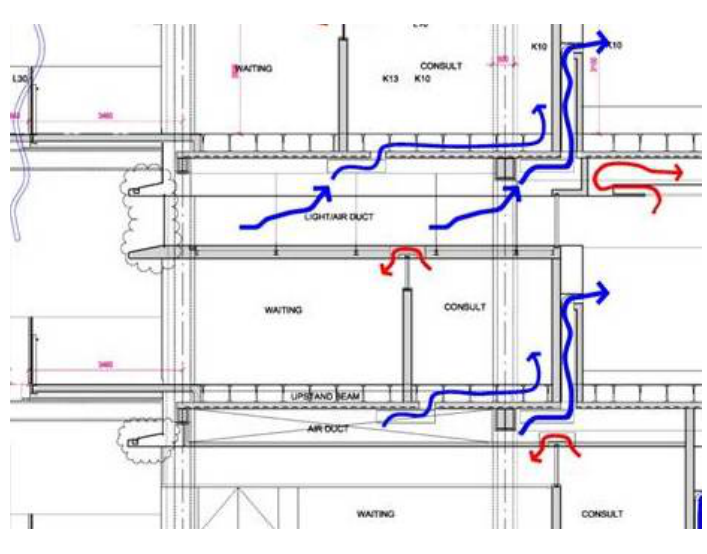
Figure 8. Light Air Duct (extract from Figure